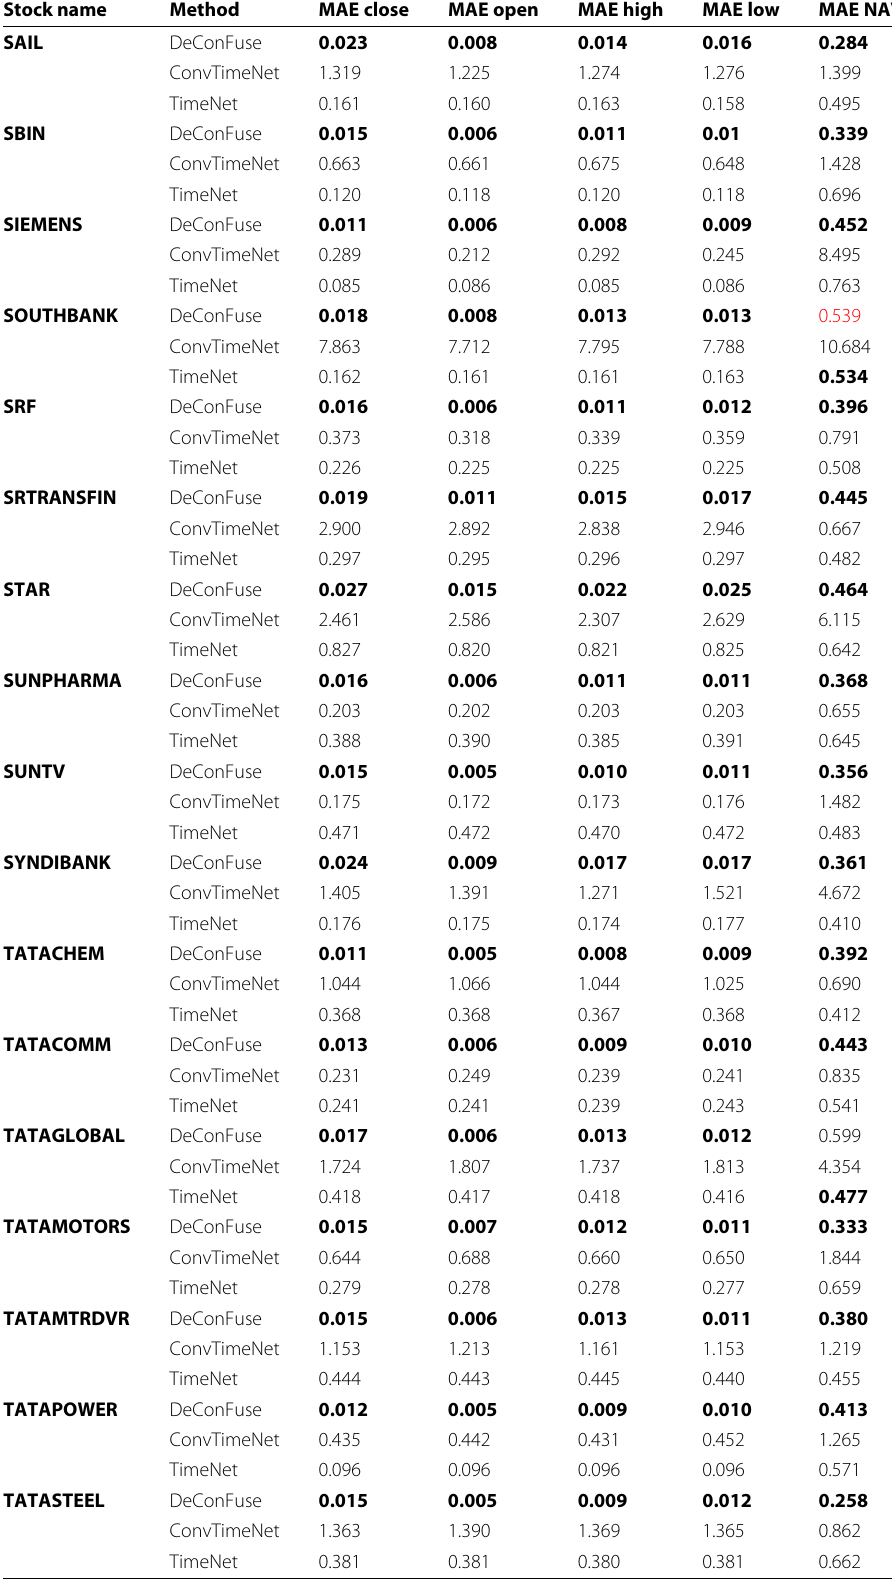
Table 5 Stock-wise forecasting results ( Continued